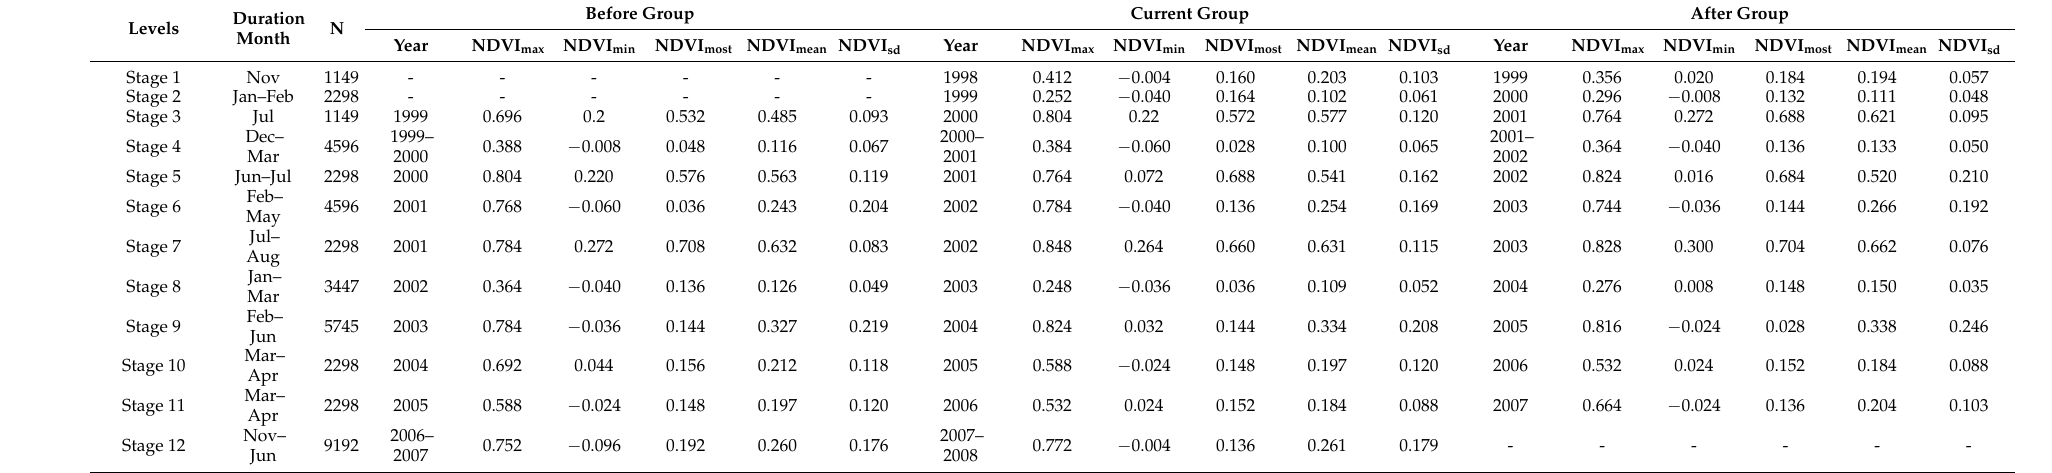
Table 2. Descriptive summary of NDVI categories of three groups in different stages of water